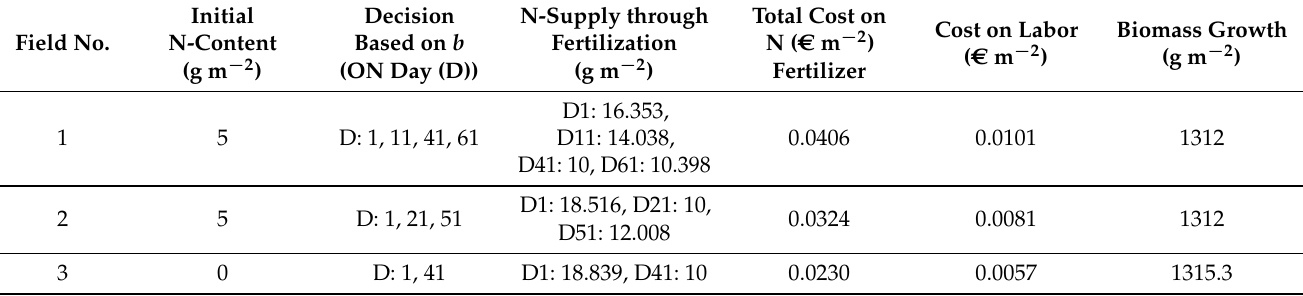
Table 4. Case 2 result: Maximum growth considering the cost of labor and resources for multiple